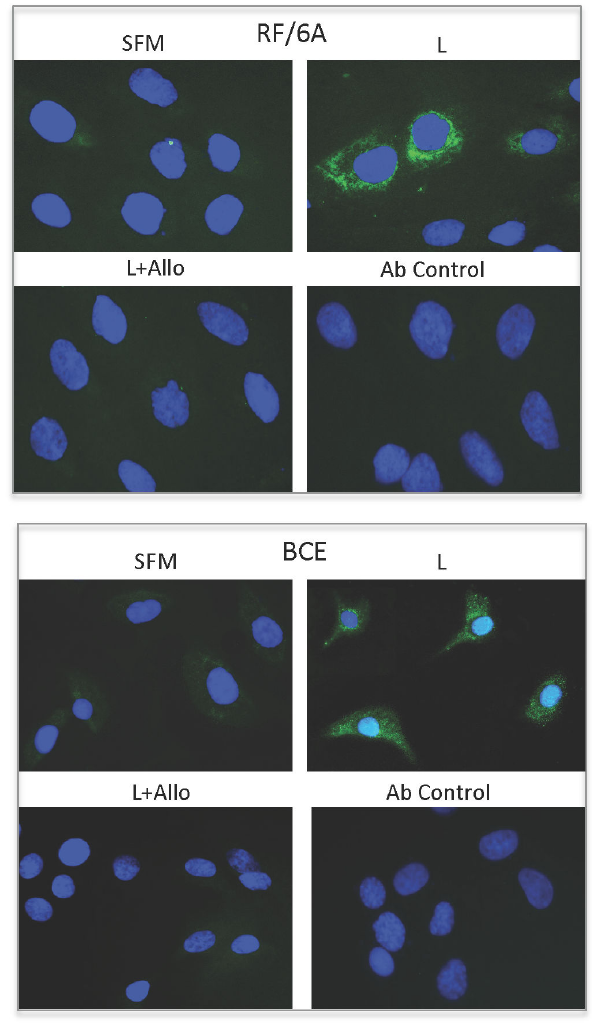
Figure 9. Effects of leptin and Allo-aca on leptin protein expression in RF/6A and BCE cells. RF/6A and BCE cells were synchronized in SFM and stimulated with 250 ng/mL leptin (L) for 24 h in the presence or absence of 100 nM (for RF/6A) or 250 nM (for BCE) Allo-aca (Allo). The expression of leptin protein (green immunofluorescence) in treated and untreated cells was detected with specific Abs, as described in Materials and Methods. In control experiments, the primary Ab was